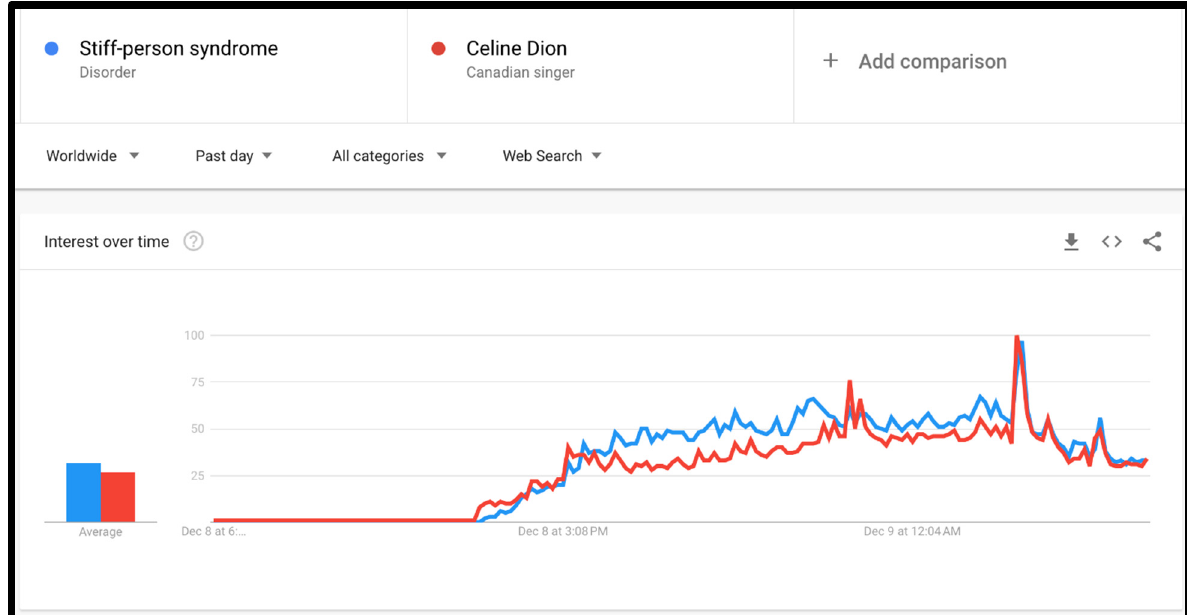
Figure 1. GT search volume related to the search terms “Stiff-person syndrome” and “Celine Dion” on the day the announcement was made by the singer.